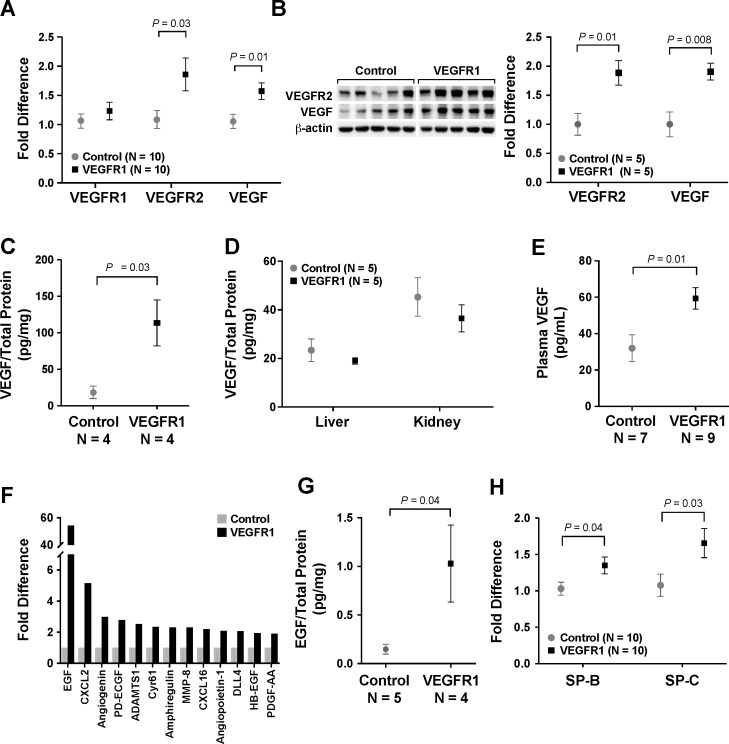
VEGFR1 increased expression of angiogenic factors and surfactant production.On quantitative polymerase chain reaction (qPCR), mice treated with VEGFR1 (20 μg/kg) demonstrated increased expression of VEGF and VEGFR2 in the lung (A). The increase in pulmonary VEGF and VEGFR2 expression was also seen on immunoblot (B). Increased pulmonary levels of VEGF with VEGFR1 treatment was also confirmed on an enzyme-linked immunosorbent assay (ELISA) (C). Meanwhile, there was no change in VEGF levels in non-regenerating organs, including liver and kidney (D). However, there was an increase in plasma VEGF concentration (E). There was also an increase in pulmonary expression of many other angiogenic and mitogenic factors, most notably epidermal growth factor (EGF), as demonstrated by an angiogenesis antibody array (F). This increase in EGF level was also confirmed by ELISA (G). VEGFR1 treatment also upregulated surfactant protein (SP)-B and -C (H). Data are expressed as mean ± standard error (SE).